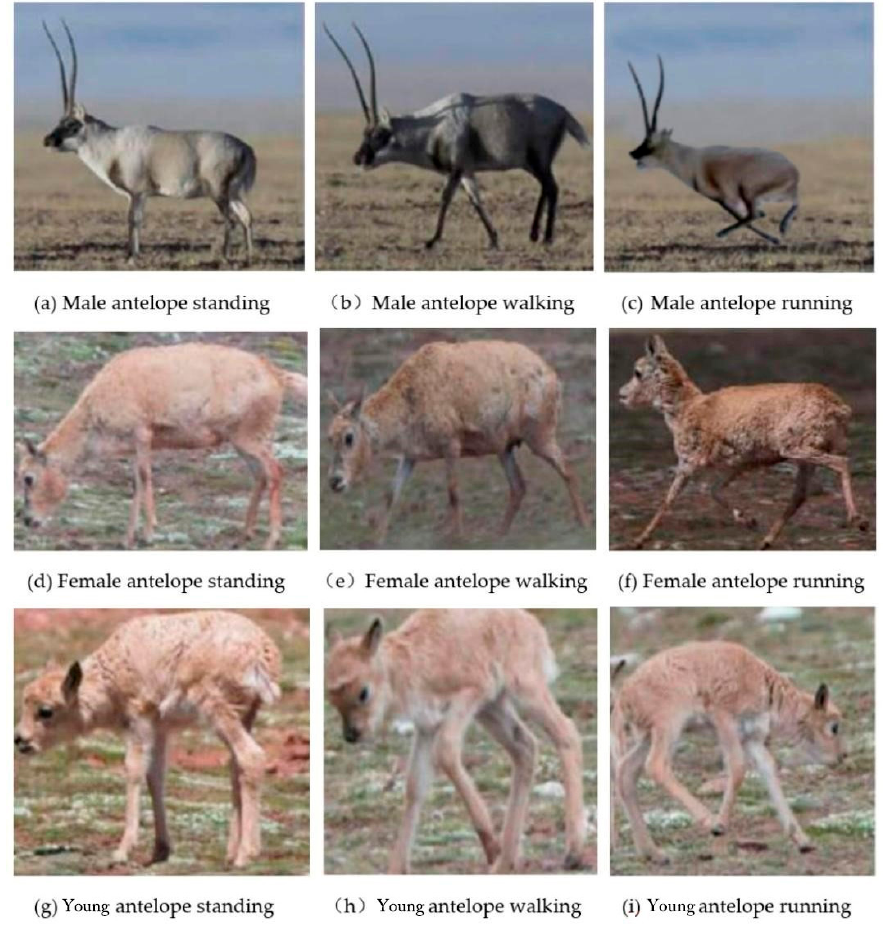
Figure 2. Male, female, and young antelopes with different motions.